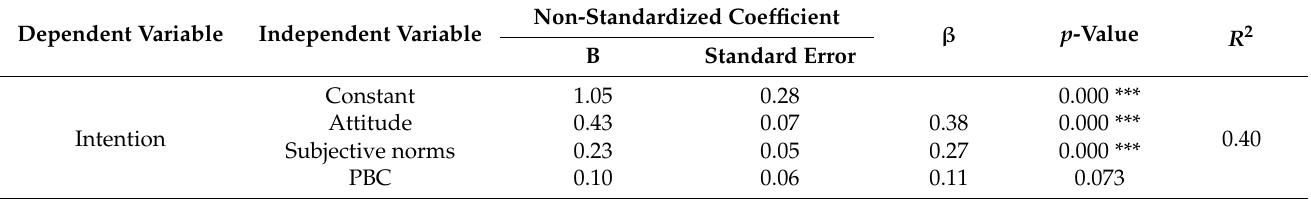
Table 4. Effects of TPB factors on intention ( n =